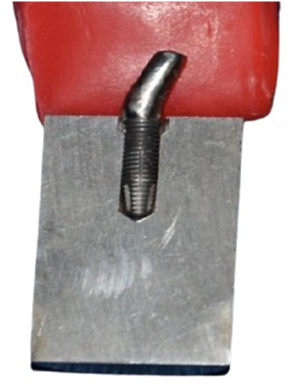
Figure 2. Sagittal view of the implant–abutment assembly.